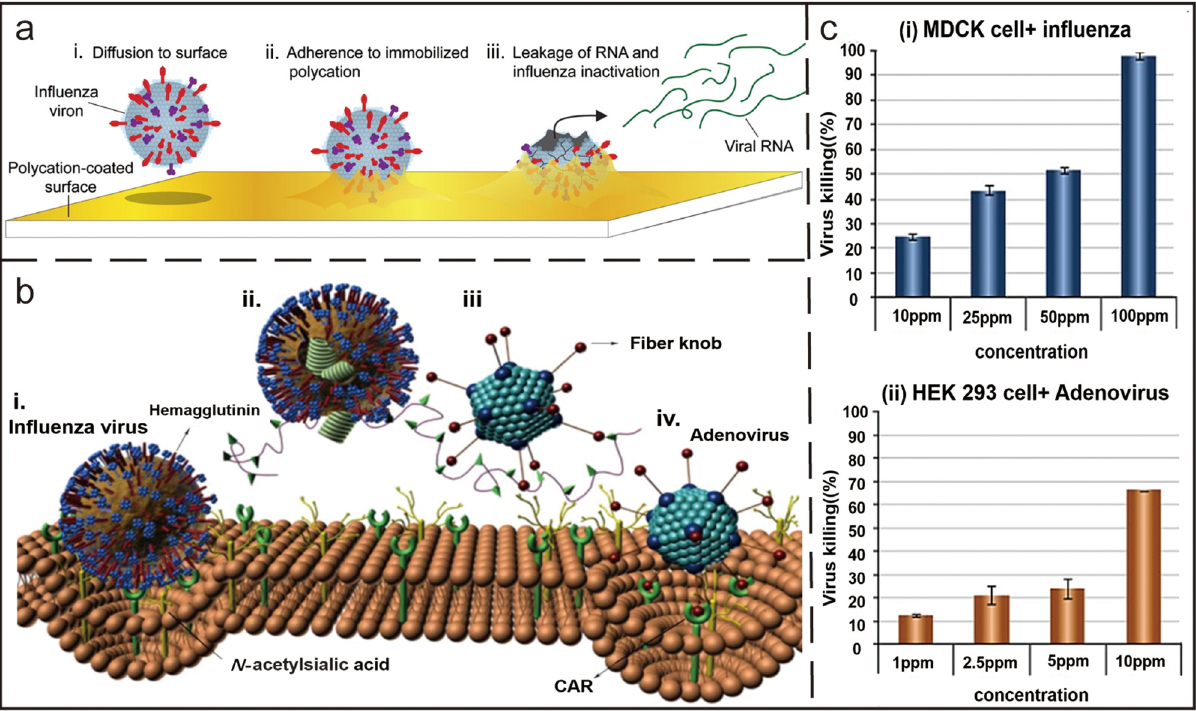
Figure 7: ( a ) Mechanism of in fl uenza virus inactivation by N,N - dodecyl, methyl - PEI coatings [ 60 ] . ( b ) PQAA antiviral mechanism: ( i ) binding of in fl uenza virus to the N - acetylsialic acid receptor and engulfment by the cellular membrane, ( ii ) penetration of PQAA into the viral envelope followed by lipid destruction, ( iii ) inhibition of PQAA on ADV entry via blocking the association between CAR receptor and fi ber protein, and ( iv ) binding of ADV to the CAR receptor mediated by the fi ber protein and formation of Clarin pit. ( c ) Antiviral activity of PQAA against in fl uenza virus ( i ) and adenovirus ( ii ) [ 61 ]